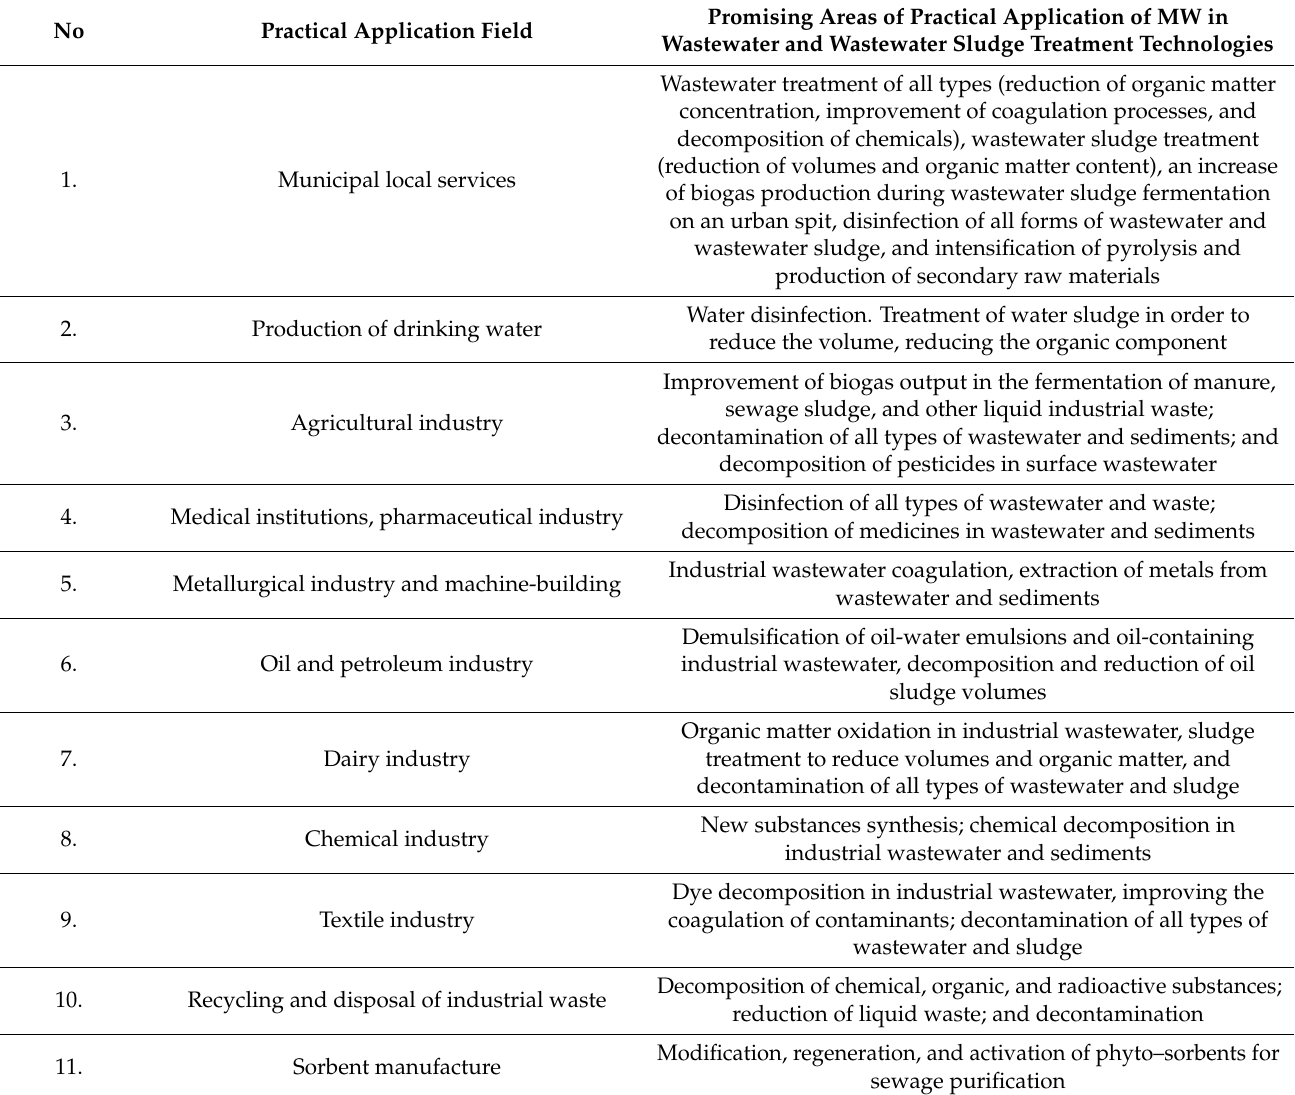
Table 12. The opportunities for practical implementation of MW in wastewater and sludge treatment